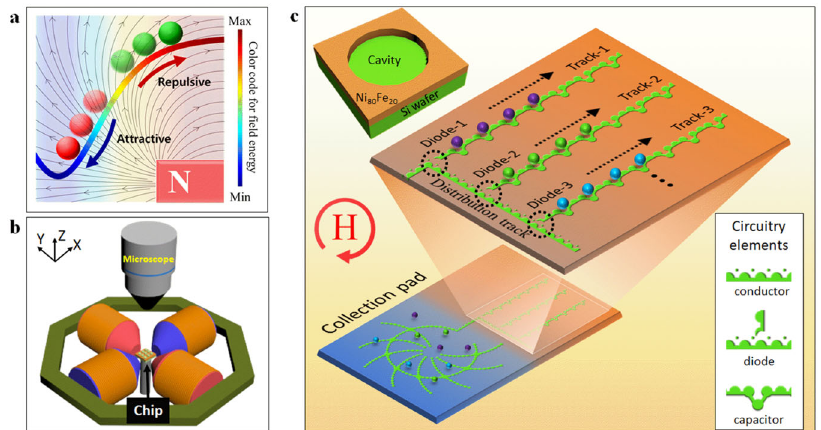
Fig. 1 Illustration of the different sizes of PsD holes storage occupancy under magnetic fi elds. a Conceptual diagram for a PsD hole (green spheres) being pushed away from the magnet. This indicates that the PsD hole moves to a higher magnetic fi eld energy, which is opposite to the magnetic particles (red spheres) moving towards a lower fi eld energy. b Schematic diagram of the electromagnetic coil setup. The micro-magnetic chip is placed at the center, which can be observed through a microscope. c Schematics of the integrated platform for the collection, distribution, transportation, sorting, and storage of PsD holes. Here, thin permalloy negative micro-magnetic (mattertronic) circuitry elements perform conduction, sorting at the eclipse diode, and storage of different sizes of PsD holes in individual capacitors under clockwise rotating magnetic fi elds. Each track allows only one size of PsD hole through the gaps designed at the T-shaped junction. Spheres shown in purple, green, and light blue correspond to PsD holes of different